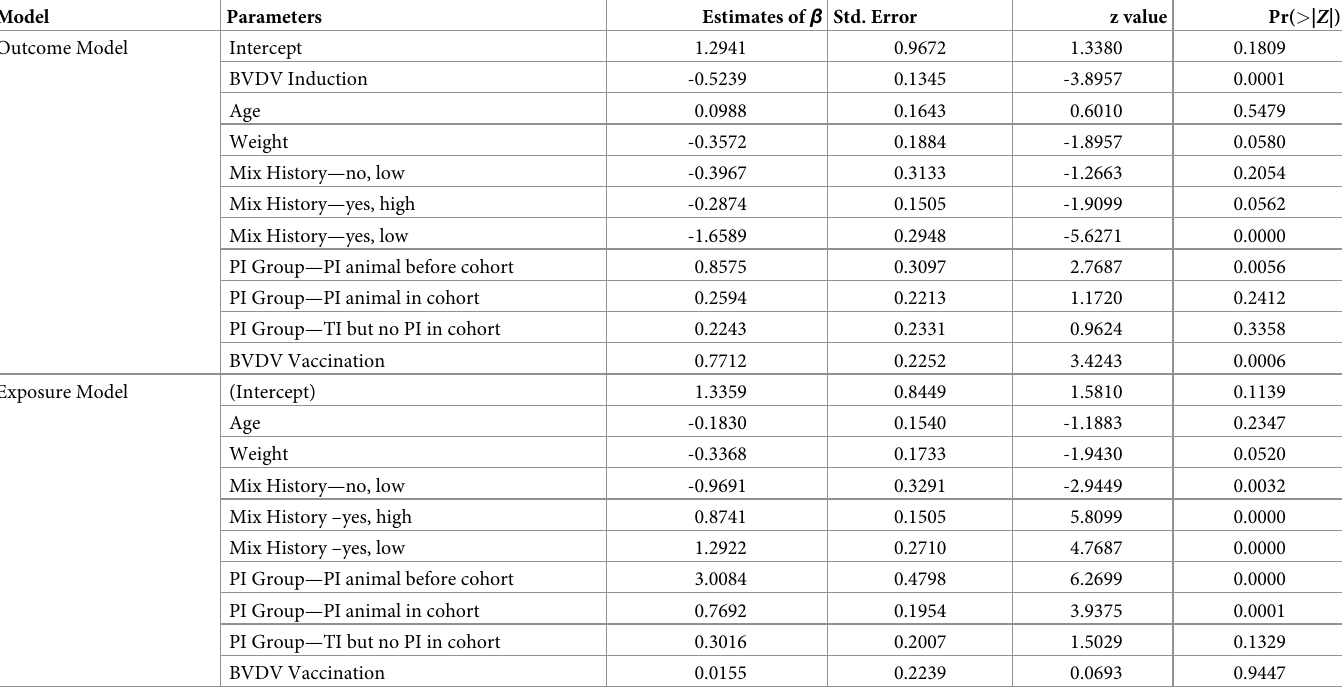
Table 3. Parameter estimates from the outcome and random feedlot effect exposure